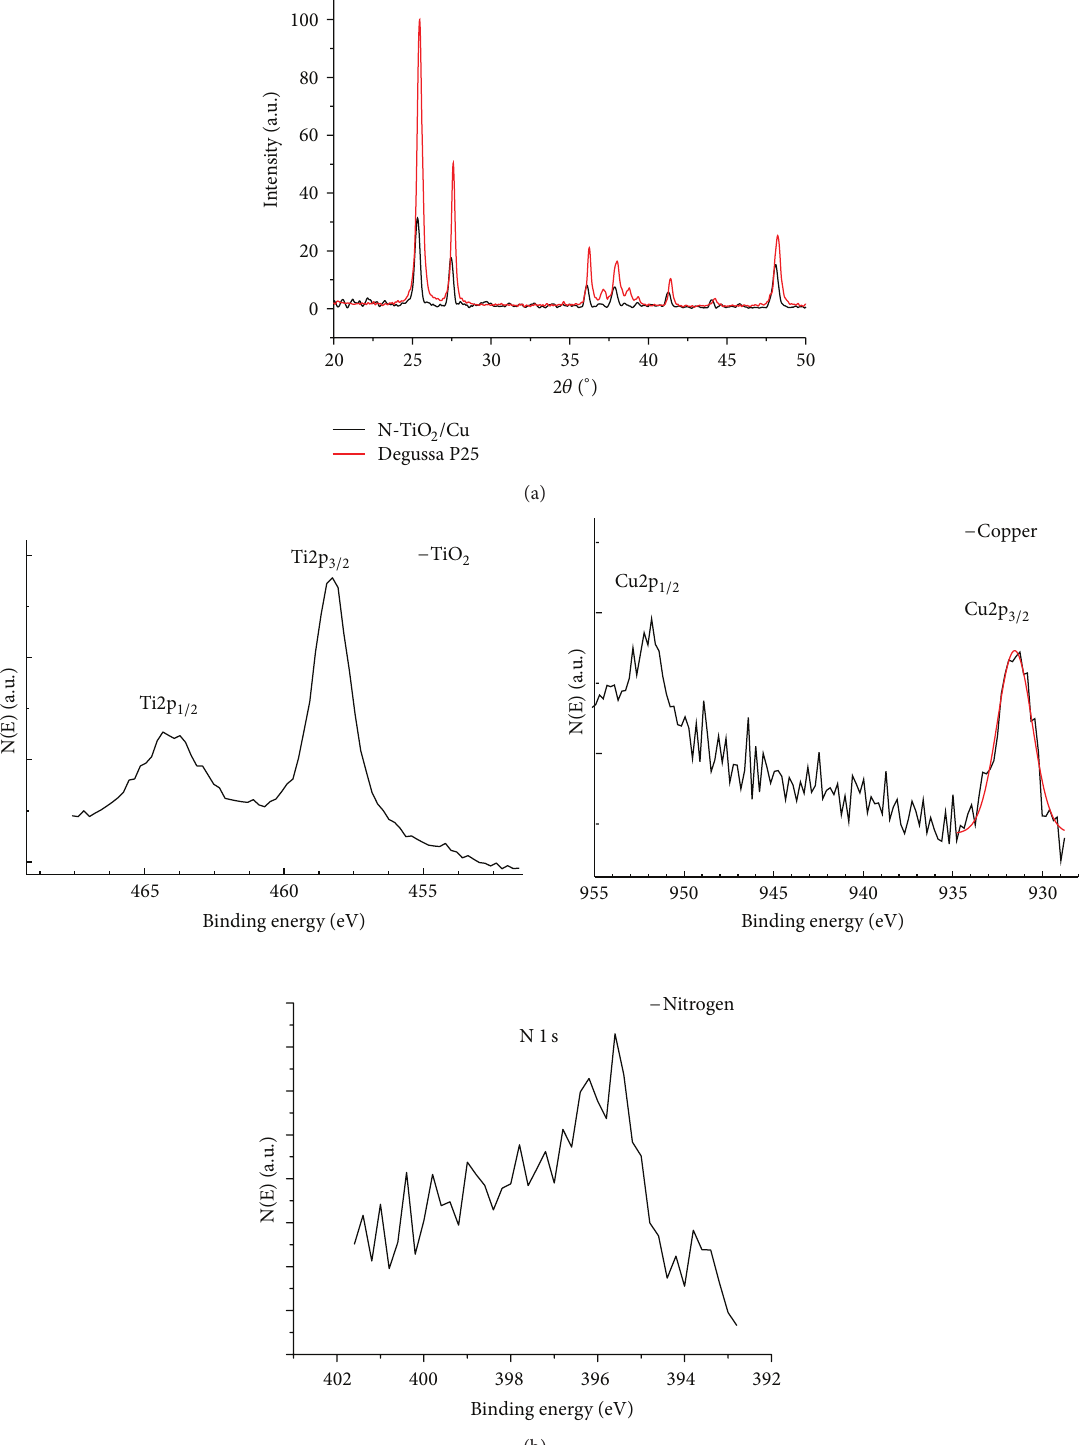
Figure 1: (a) X-ray diffraction spectra of TiO 2 (Degussa P25) and N-TiO 2 /Cu. (b) XPS of N-TiO 2